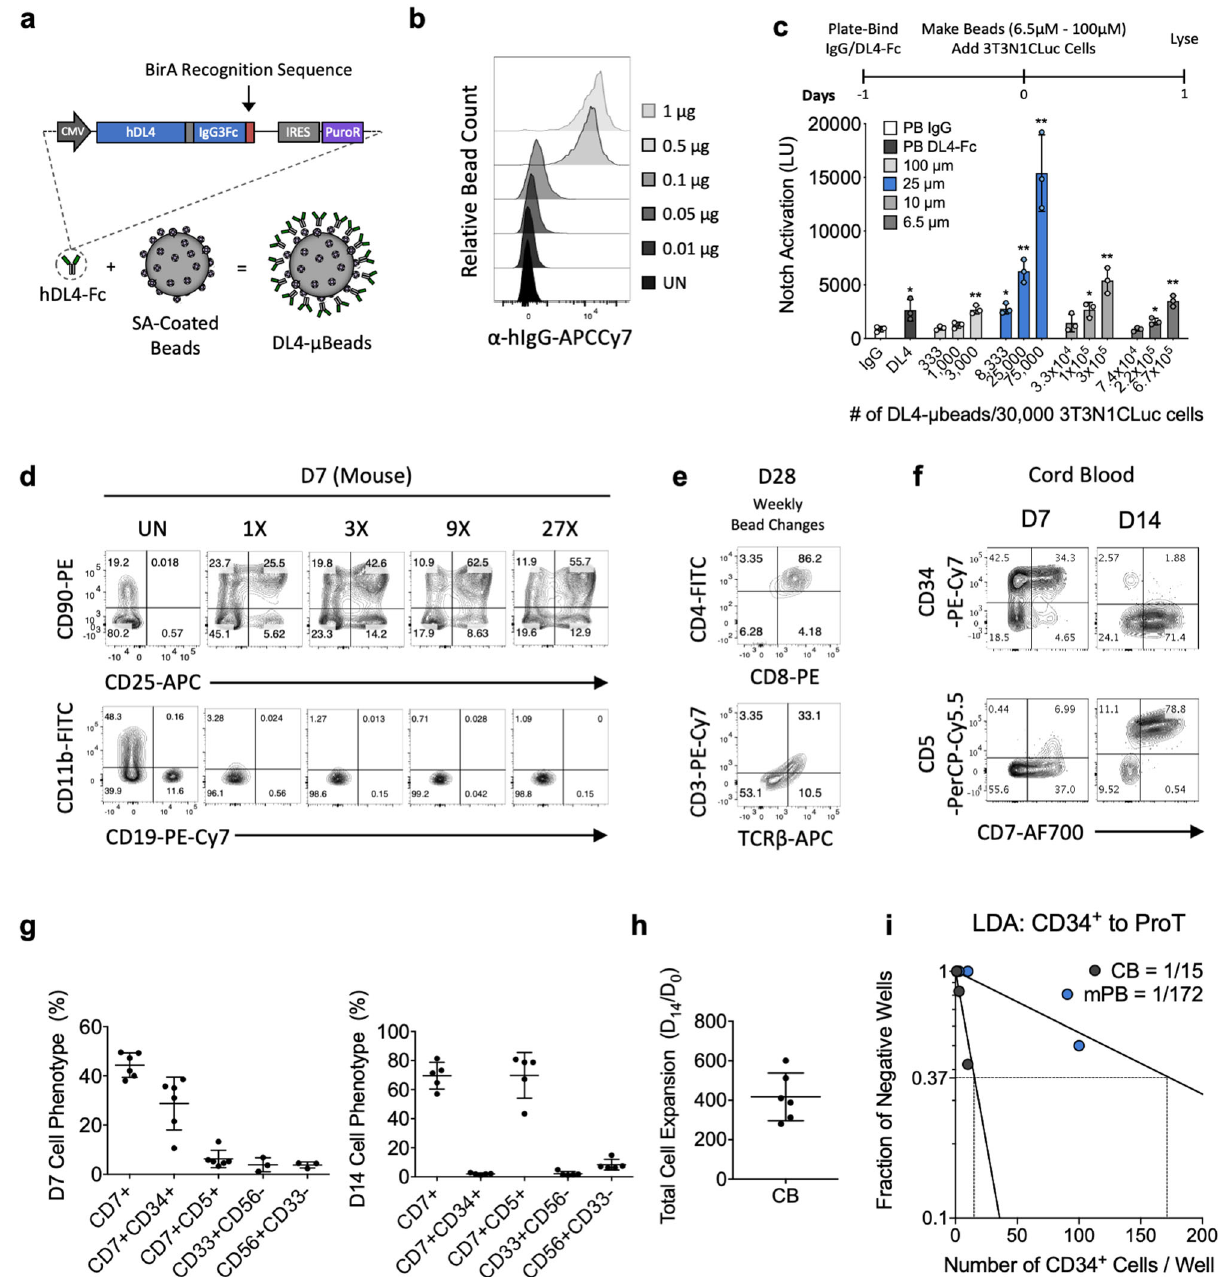
Scalability and comparison of DL4- μ beads to plate-bound DL4-Fc cultures . To extend the comparison of the DL4- μ bead system to existing stromal cell-free cultures for the generation of T-lineage cells, we performed side-by-side comparisons using CB- CD34 + cells cultured with DL4- μ beads along with plate-bound DL4-Fc (Fig. 2a). To directly compare the effectiveness of DL4-Fc when used in either platform, increasing amounts of DL4-Fc were adsorbed onto tissue culture-treated plates (1 μ g/mL to 9 μ g/mL), with 1 μ g/mL being equivalent to amount bound onto the DL4- μ beads and 9 μ g/mL being equivalent to what has been estab- lished in the literature. Cultures with DL4- μ beads gave rise to CD7 + CD5 + cells at a similar frequency and cell yield as that observed with DL4-Fc adsorbed at 3 and 9 μ g/mL. Of note, cultures with DL4- μ beads signi fi cantly outperformed those with DL4-Fc adsorbed at 1 μ g/mL. Additionally, an LDA analysis of T